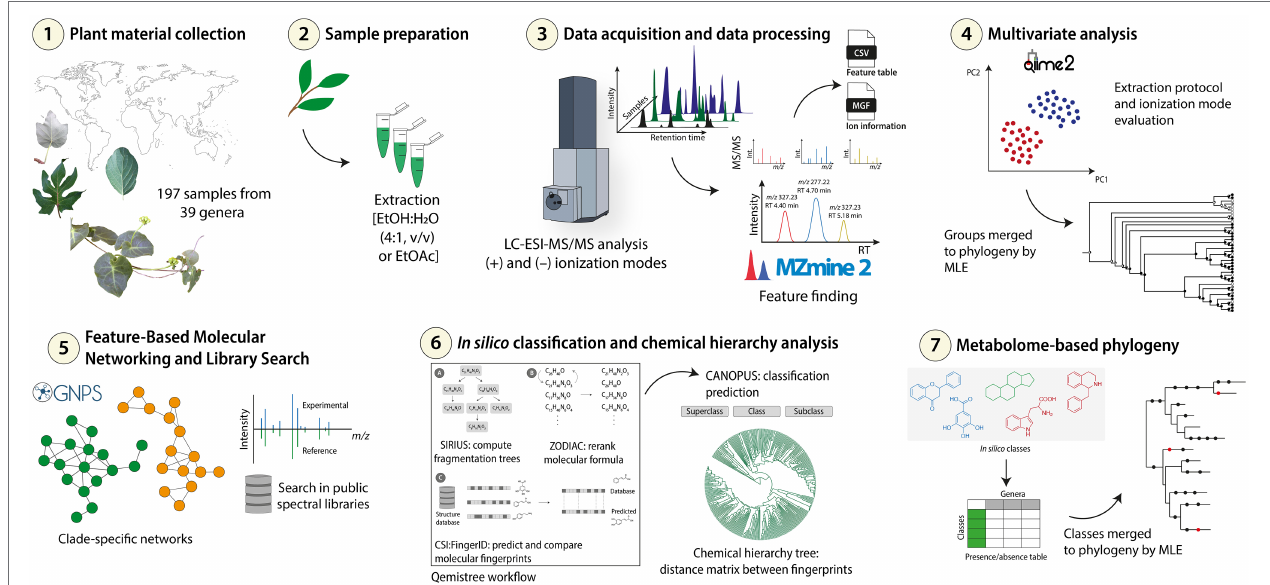
FIGURE 1 | Experimental workflow followed for the metabolomics and chemosystematics analyses of Malpighiaceae samples. (1) The samples were initially collected, (2) the extracts were prepared with different solvents [EtOH:H 2 O (4:1, v/v) or EtOAc], and then (3) subjected to LC-ESI-MS/MS analysis in positive and negative ionization modes in an untargeted method. (4) The data acquired were processed for feature finding, and the exported data were used for multivariate analysis. The clustering groups observed were merged to the phylogeny using the Maximum Likelihood Estimation (MLE) for preliminary chemotaxonomic investigations. (5) The data were also used for Feature-Based Molecular Networking and library searches workflows to observe clade-specific molecular families. (6) A chemical hierarchy analysis and in silico classifications were obtained and finally (7) merged to the currently accepted Malpighiaceae phylogeny to determine the ubiquitous and the taxa-specific in silico